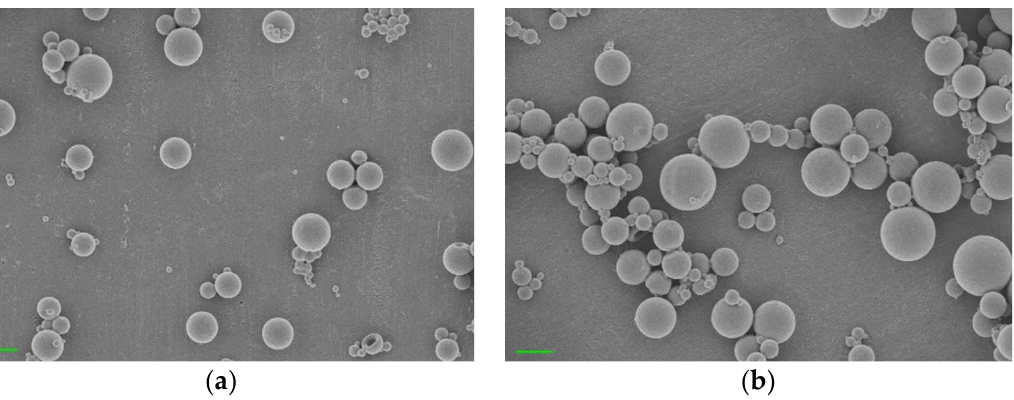
Figure 2. The representative FE-SEM images of Dex-loaded ( a ) PLGA microparticles and ( b ) PLGA/PBMP microparticles. Each scale bar represents 1 μm. Table 1. Characteristics of Dex-loaded PLGA and PLGA/PBMP microparticles a .